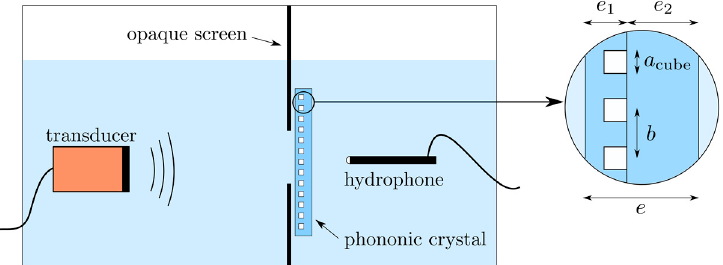
Figure 3. Setup for acoustic transmission measurements. A short ultrasonic pulse is emitted from the transducer and the transmission is probed using a hydrophone. Sample parameters are (cid:1853) (cid:3030)(cid:3048)(cid:3029)(cid:3032) (cid:3404) 590 μm, (cid:1854) (cid:3404) 2 mm, (cid:1857) (cid:2869) (cid:3404) 0.8 mm,(cid:1857) (cid:2870) (cid:3404) 5 mm .